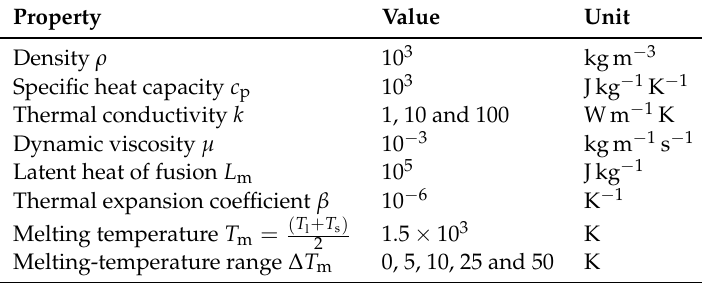
Table 1. Thermophysical properties of the artificial materials used in the simulations.